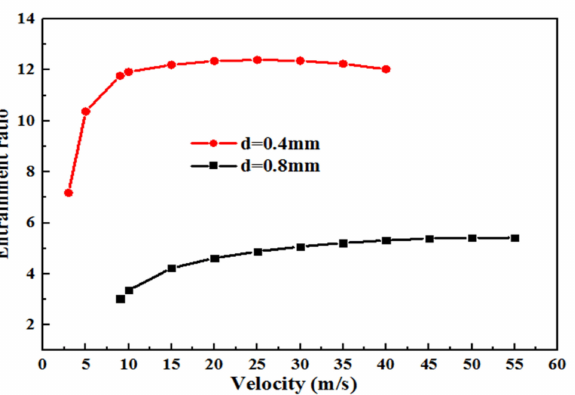
Figure 10. Air entrainment ratio vs. jet velocity for the two combustors with different nozzle exit